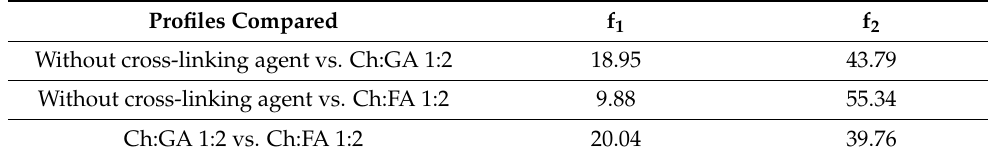
Table 4. The values of difference (f 1 ) and similarity (f 2 ) factors for the tested pairs of vitamin E release